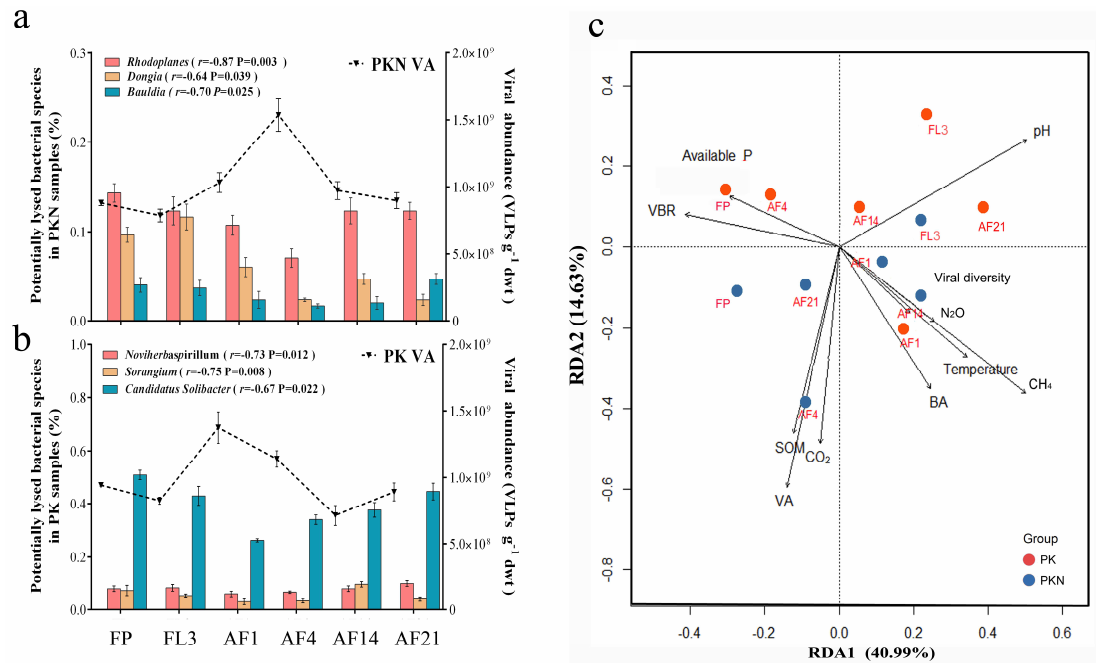
Figure 4. Bacterial community structure driven by potential specific viral predators and related factors. ( a , b ) The bar plots show the top three bacterial genera which most negatively correlated with the viral abundance (VA) over time (the correlation coe ffi cient and significance are shown in the legends); ( c ) RDA analysis of all samples, indicating how was bacterial community driven by virus and other environment factors. The percentage of the variance explained by each axis is indicated in parenthesis. Red and blue filled circles indicate bacterial community of PK and PKN groups, respectively. VA, bacterial abundance (BA), VBR (virus-to-bacterium ratio), viral diversity index, microbial processes, and environmental variables are showed by arrows. Arrow length indicates the importance of a corresponding parameter; a small angle between two arrows indicates a strong correlation between the two corresponding parameters. Additionally, “Temperature” means soil temperature at 5 cm depth. “Viral diversity” means viral Shannon index. FP, representing spring fallow period; FL3, third day of flooding; AF1, 4, 14, 21 refer to the first, fourth, 14th, and 21st days after fertilization,